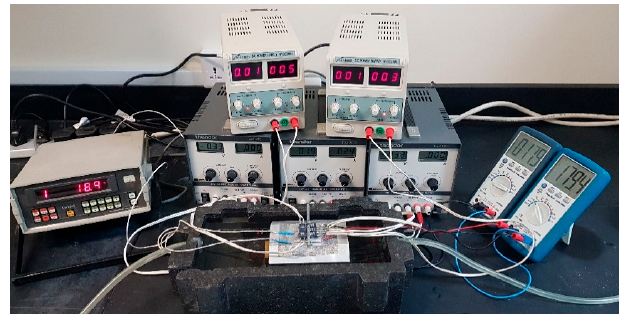
Figure 3. Experimental setup used.